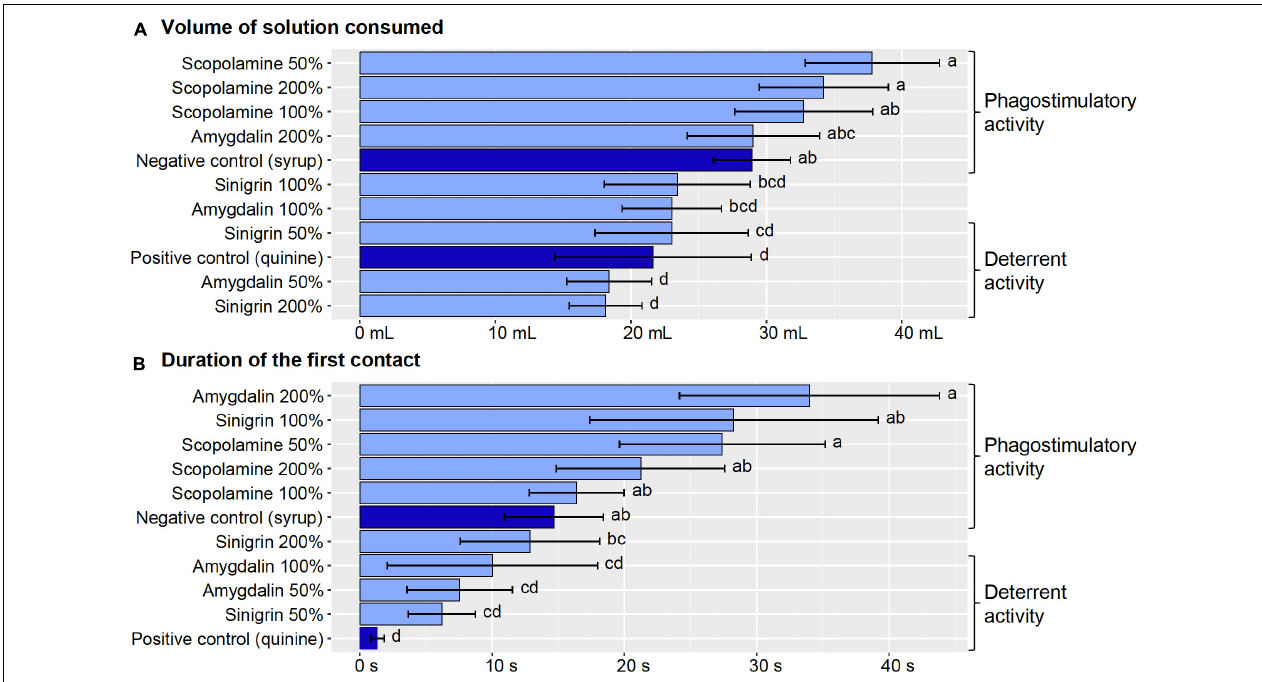
FIGURE 3 | Phagostimulatory or deterrent activity of the specialized metabolites. (A) Volume of solution consumed, and (B) duration of the first contact with the solution during preference experiments. Different letters indicate significant differences ( p < 0.05) between treatments. Controls are depicted in dark blue, all test solutions are depicted in light